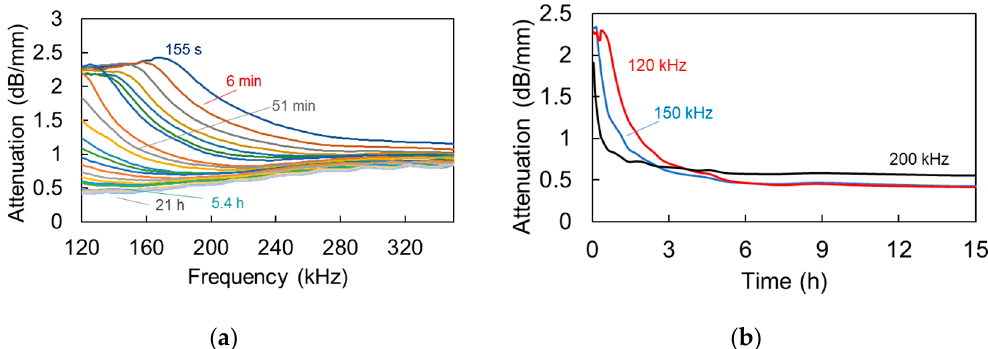
Figure 10. ( a ) Attenuation vs. frequency curves for different times and ( b ) attenuation of specific frequencies vs. time of shampoo.